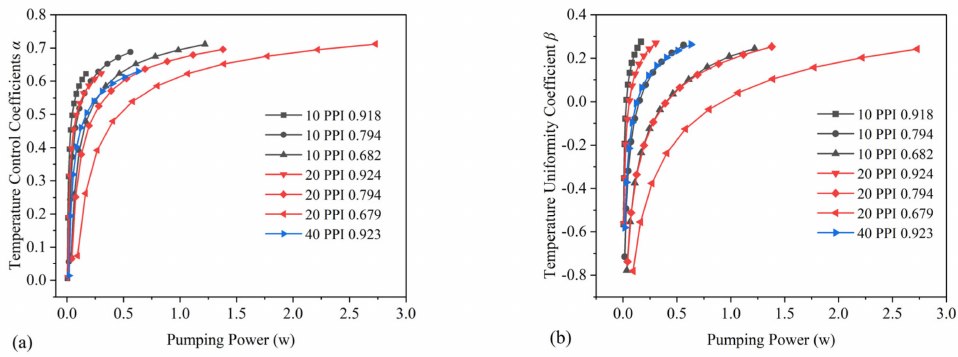
Figure 8. ( a ) Temperature control coefficient α , ( b ) temperature uniformity coefficient β .